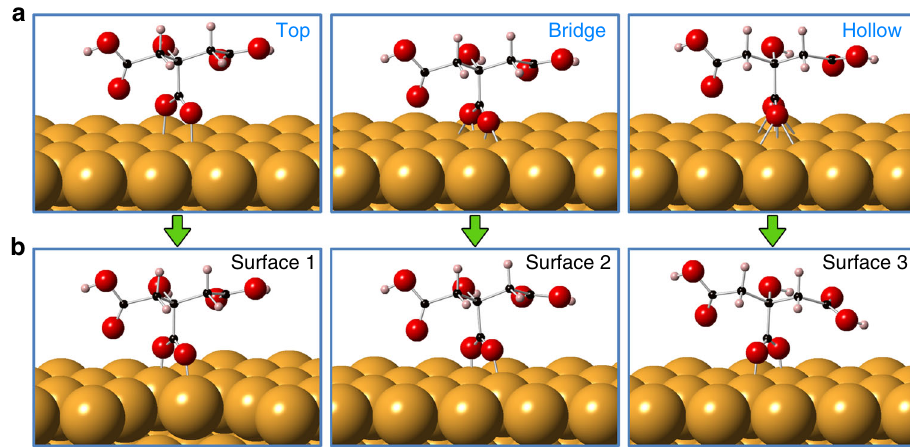
Fig. 4 Con fi gurations of citrate ligands adsorbed on gold {111} surfaces. a Possible con fi gurations: Top, bridge and hollow, depending on the binding position of oxygen atoms, are applied as the initial states. b After relaxation, citrate in both bridge and hollow con fi gurations change their location to the top of the gold atoms, indicating that the top con fi guration is the most stable one. Atoms are noted with colors (yellow: gold; red: oxygen; black: carbon; pink: